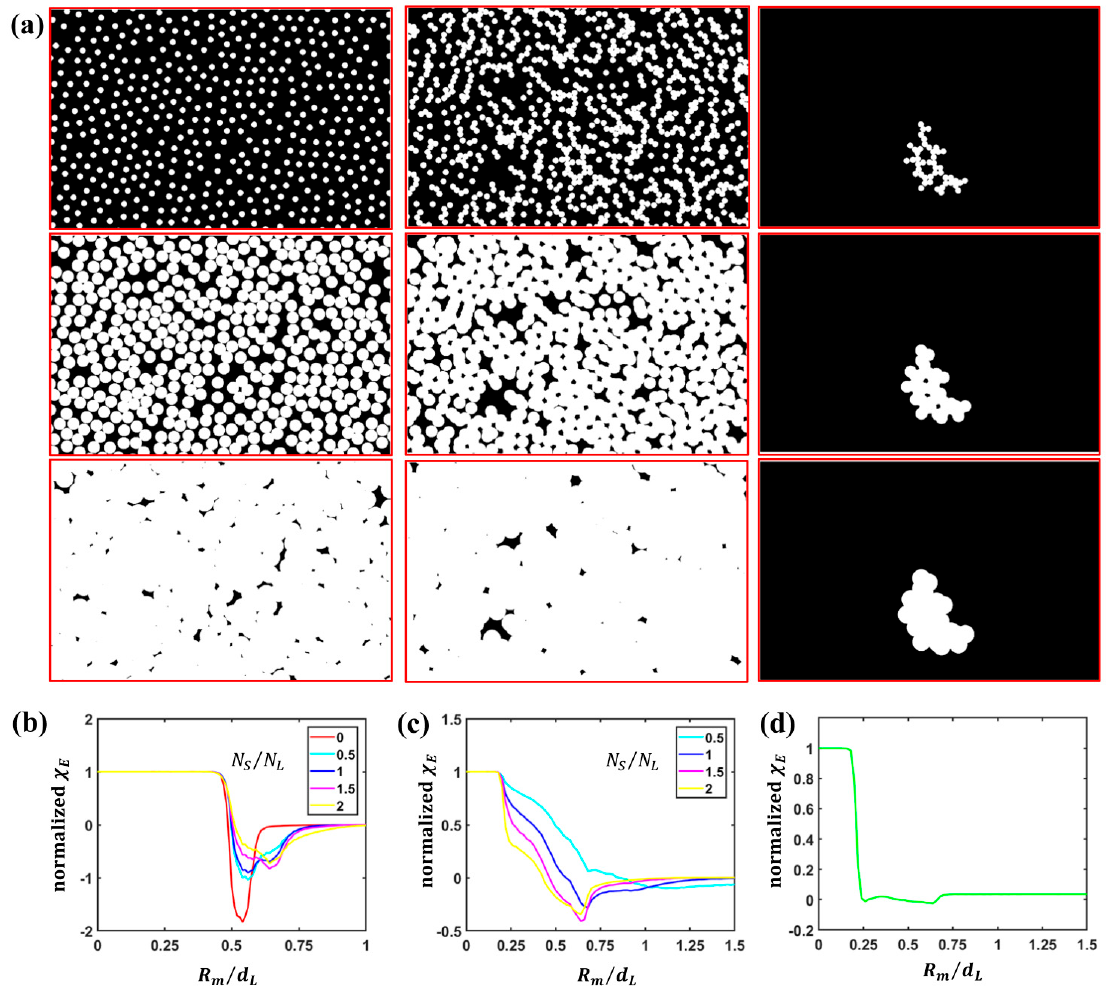
Figure 4. Minkowski functional analysis of small particle arrangements: ( a ) Graphical representation of the construction of patterns for Minkowski functional analysis for an increasing cover disc radius R m in case of L particles (left column), S particles (central column) and S particle clusters of size N ≥ 19 (right column); ( b ) normalized Euler characteristic χ E computed for L particles for variable particle number ratio N S /N L ; ( c ) normalized Euler characteristic χ E computed for S particles for variable particle number ratio N S /N L ; ( d ) normalized Euler characteristic χ E computed for S particle clusters of size N ≥ 19 .